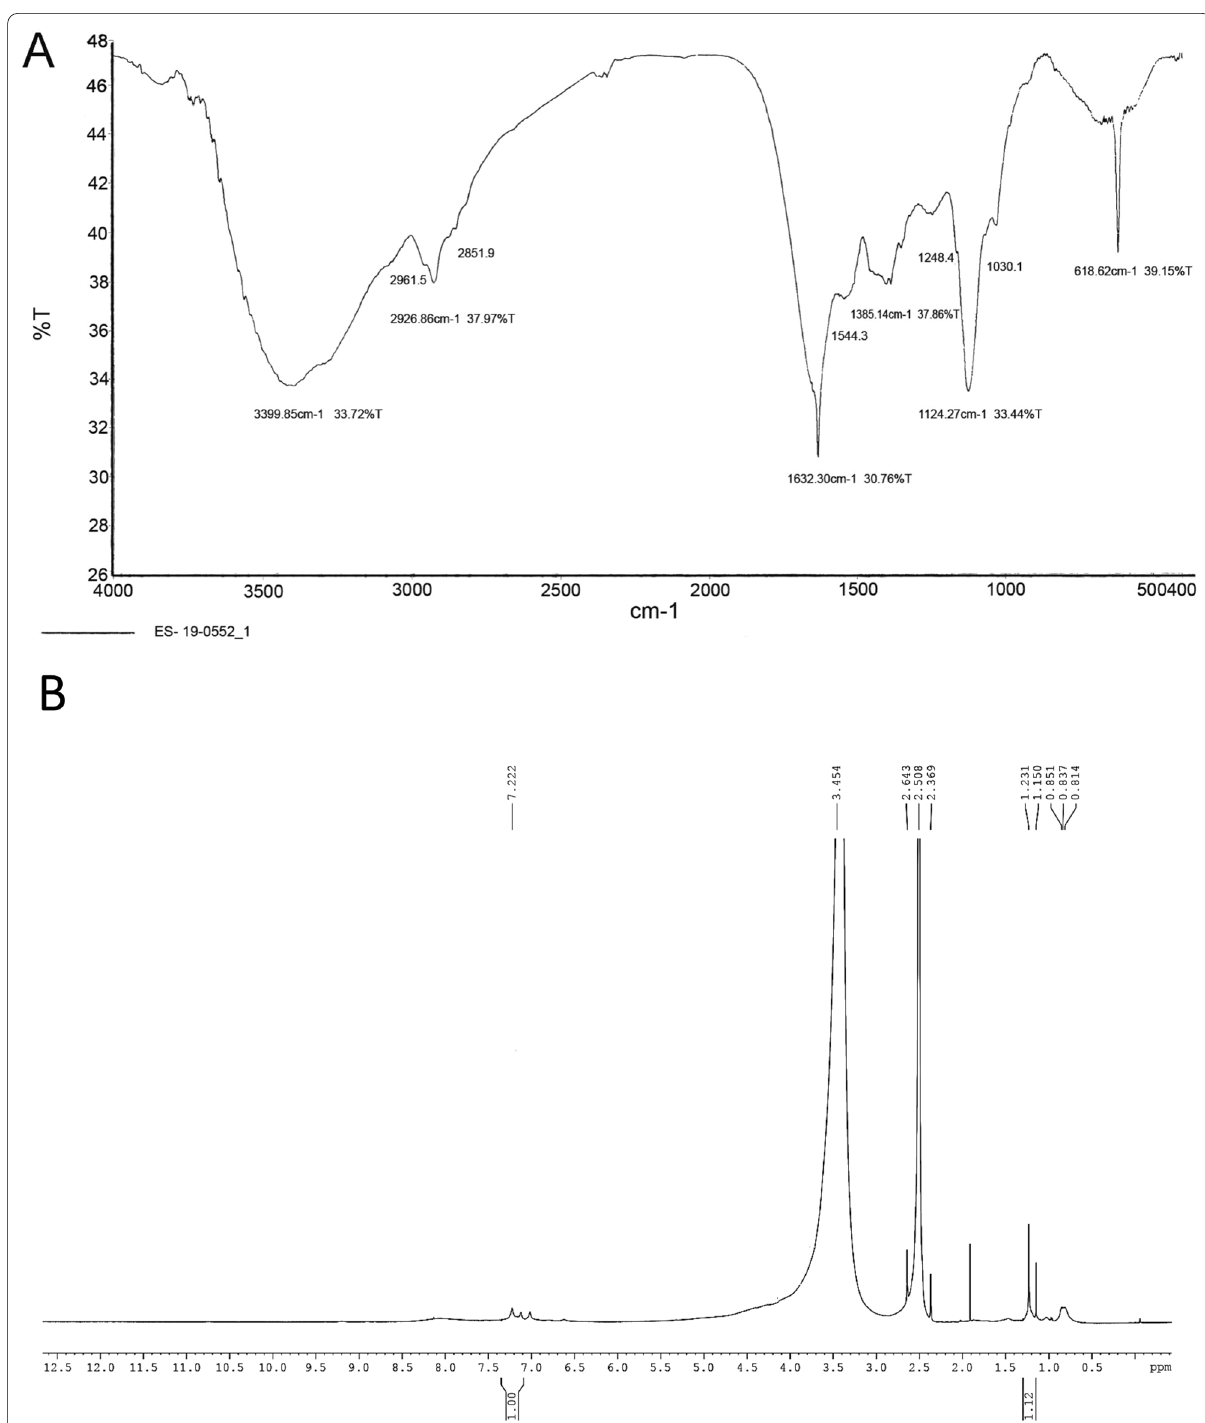
Fig. 4 Spectroscopic characterization of melanin pigment purified from T. coccinea — T. versicolor culture. A FTIR spectrum. B NMR